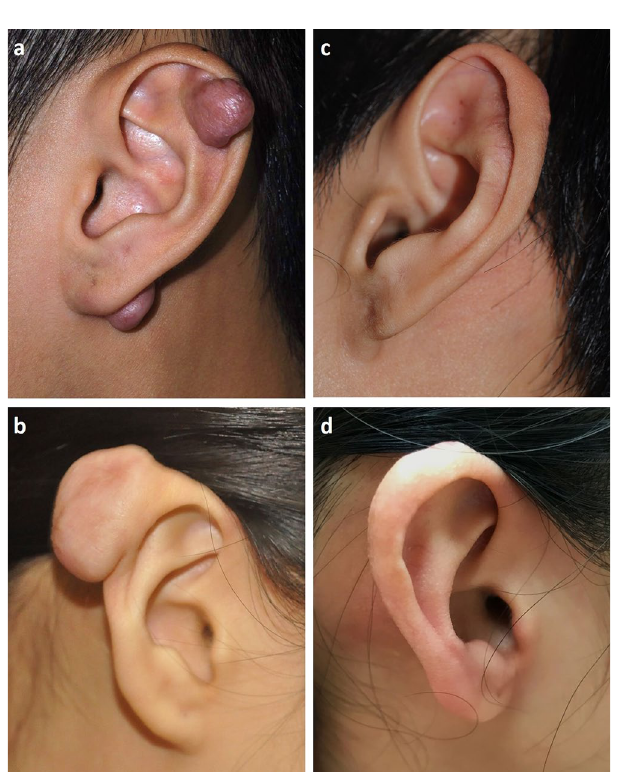
Figure 1. Clinical photographs of auricular keloids before and after treatment. ( a ) Two Chang-Park classification type I keloids located on the left ear helix and lobe. ( b ) Solitary large-sized Chang-Park classification type I keloid on the right ear helix. ( c ) The patient’s appearance in ( a ) after 20 months of treatment. ( d ) The patient’s appearance in ( b ) after 14 months of